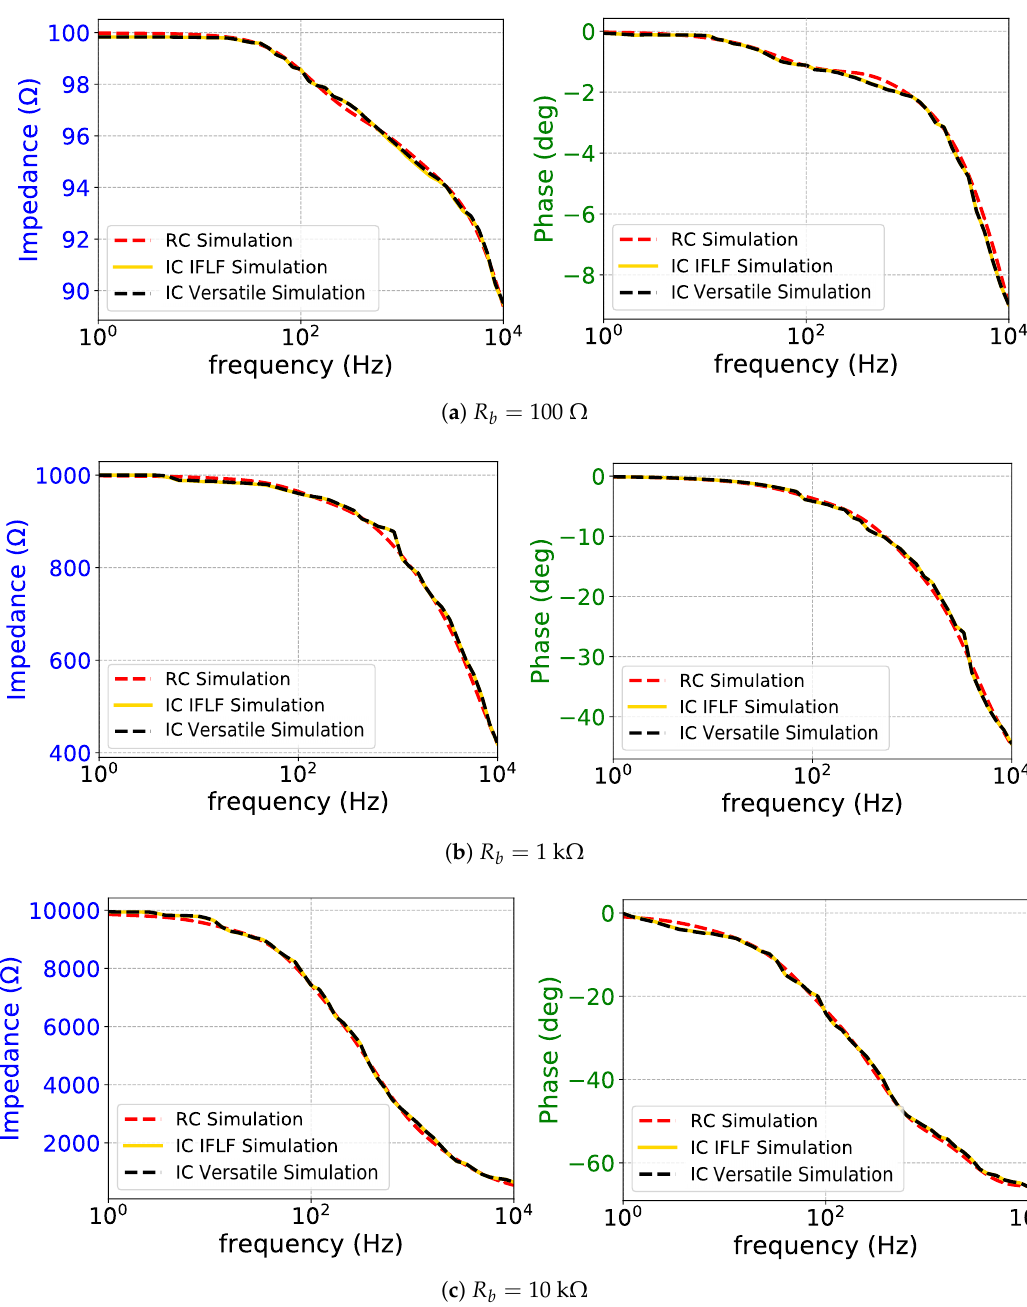
Figure 30. AC magnitude and phase impedance measurements for ( a ) R b = 100 Ω , ( b ) R b = 1 k Ω , and ( c ) R b = 10 k Ω : all electrode and contact impedances are equal ( R ∞ = 1.5 k Ω ). The corresponding RC network approximations are included for